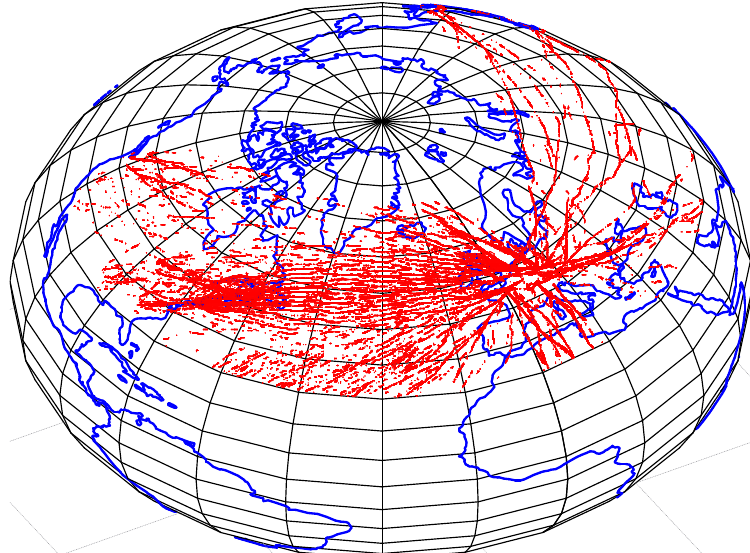
Figure 7. Map of the world centred on the north-Atlantic flight corridor. Every red dot marks a location where the combination of MOZAIC and ERA-5 data indicated a quite large instantaneous radiative forcing value for a persistent contrail at its formation, iRF > 19Wm − 2 . Note that only flights in the northern midlatitude band 30 ◦ to 70 ◦ are analysed. The figure indicates that a large iRF can occur almost